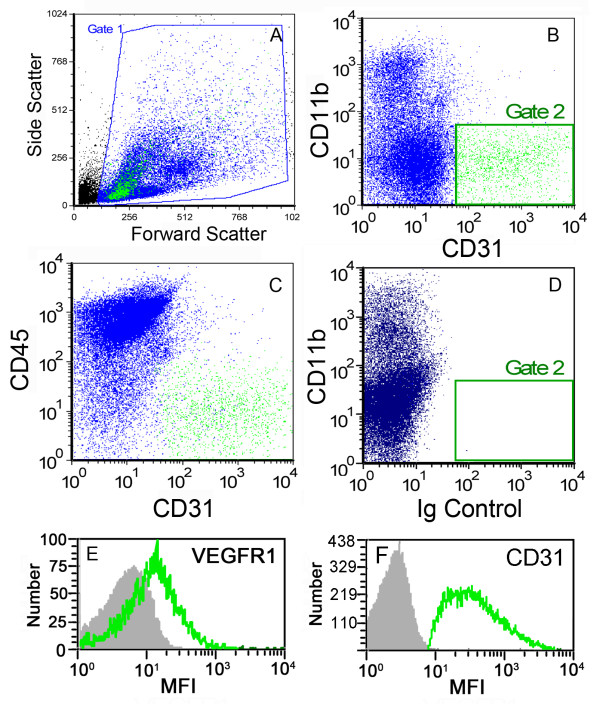
Phenotype of lung endothelial cells after enzymatic digestion. A) Flow cytometry light scatter characteristics of the digested lung cells. Gate 1 was used for subsequent dual parameter analyses. The green population in panels A-D reflect Gate 2 defined in panel B. B) Dual parameter histogram of lung cells stained with directly conjugated anti-CD31 (390, FITC) and anti-CD11b (M1/70, PE) monoclonal antibodies. C) Consistent with an endothelial phenotype, the CD31+/CD11b- cells in Gate 2 were also negative for the leukocyte antigen CD45 (30-F11, PE). D) Isotype control of the anti-CD31 antibody. E-F) Surface expression of the Flt1 (VEGFR1) and Pecam1 (CD31) gene products of the endothelial cell population presented as a single parameter histogram. Gray reflects the surface staining of the isotype control of each antibody; MFI = mean fluorescence intensity. The CD31+ cells (Gate 2) were defined as endothelial cells for subsequent experiments.